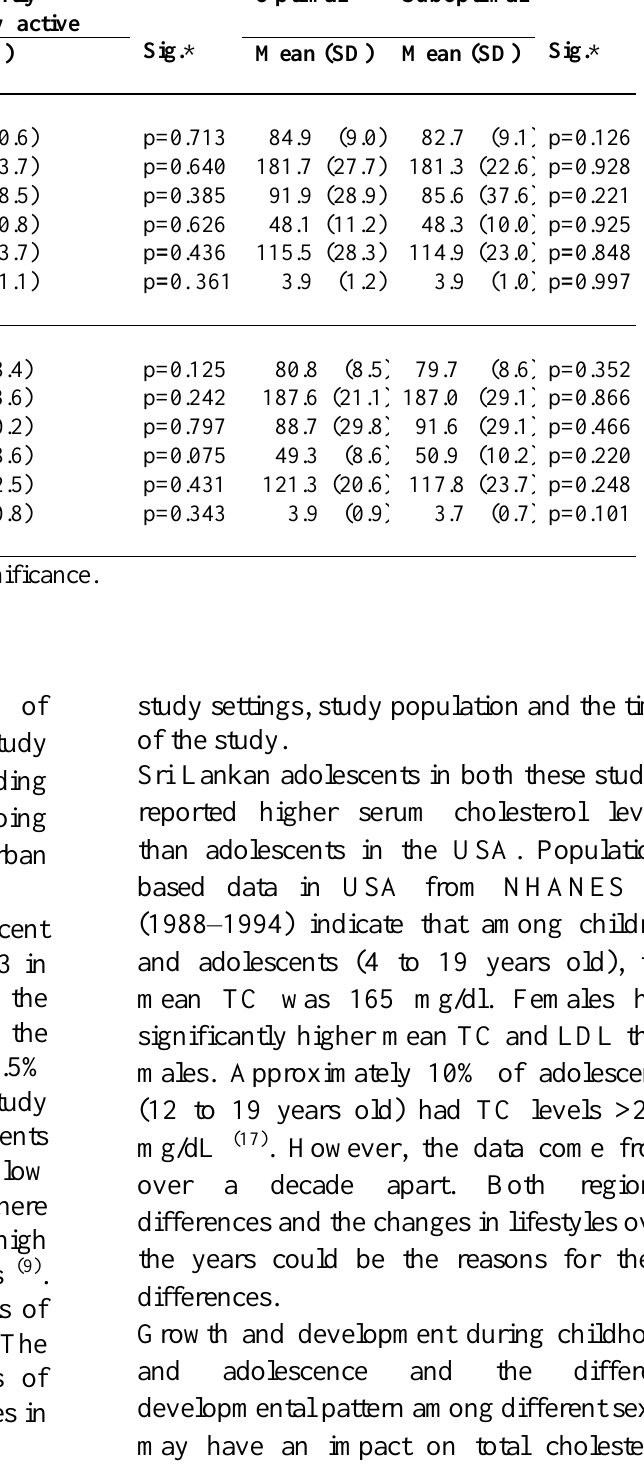
Table 5. Mean fasting blood sugar and lipid levels of male and female students according to the level of physical activity and dietary quality Fasting blood sugar (FBS) and